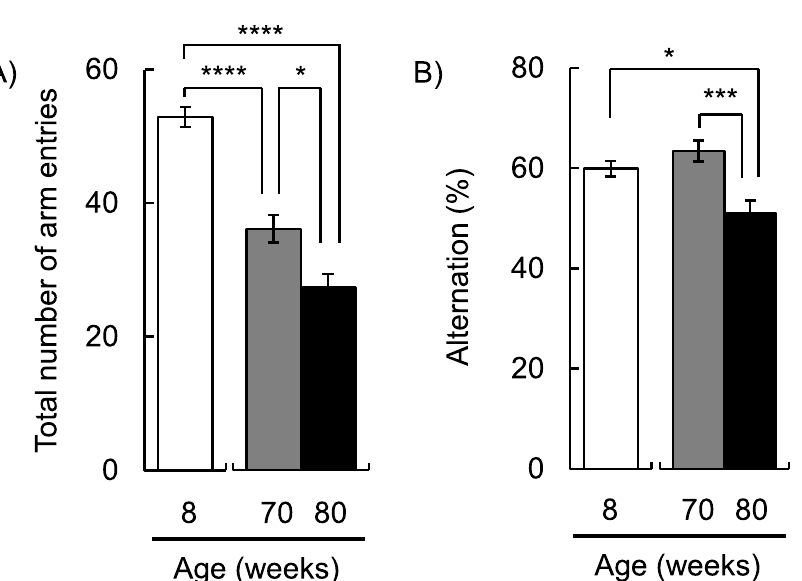
Fig 3. Short-term memory changes due to aging. (A) The total number of arm entries and (B) the alteration ratio are shown (8-week-old mice for n = 25, 70-week-old mice for n = 21, 80-week-old mice for n = 14). The total number of arm entries and alternation ratio significantly decreased with age ( F = 44.0, p < 0.0001 for the total number of arm (2 , 57) entries, F (2 , 57) = 7.77, p < 0.001 for the alternation ratio; one-way ANOVA). � p < 0.05, ��� p < 0.001 and ���� p < 0.0001 (Tukey posthoc